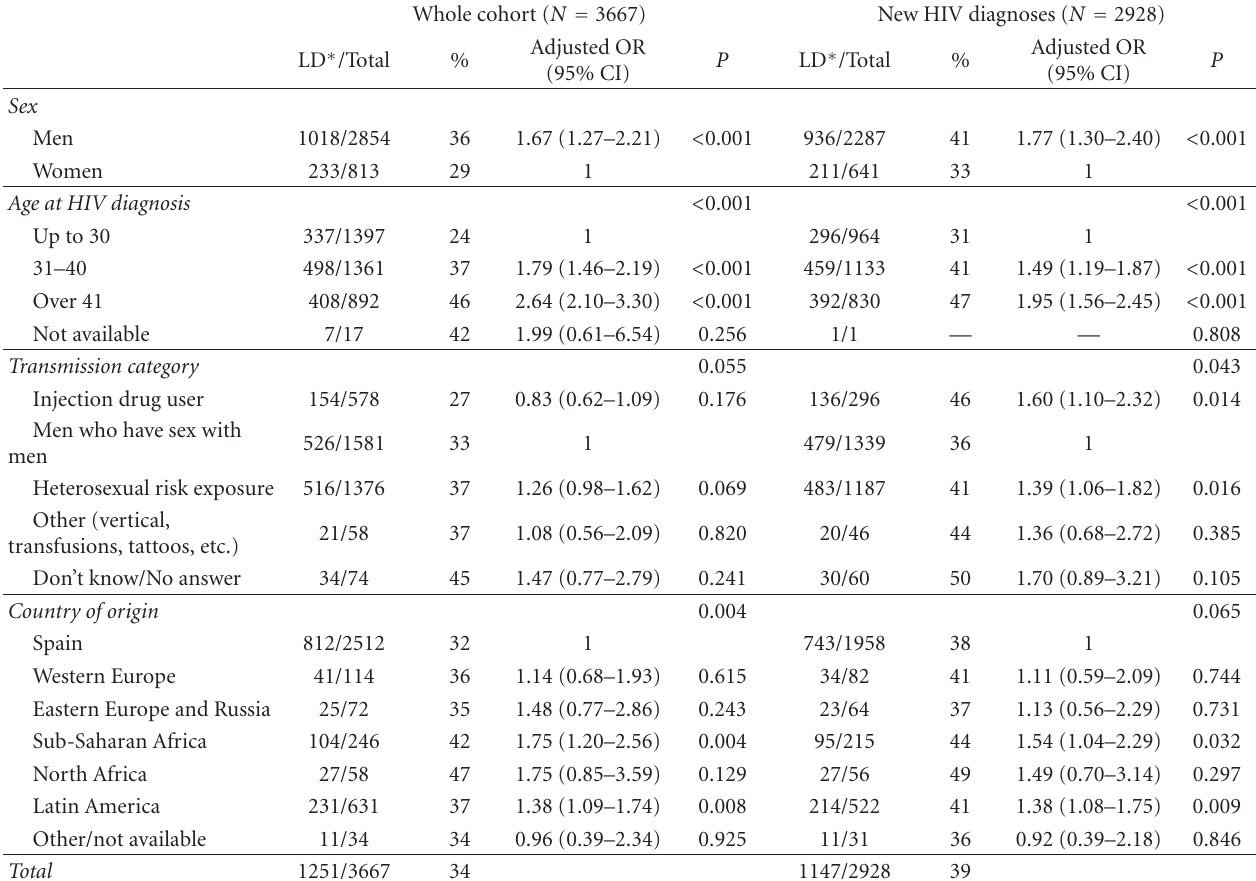
Table 2: Factors associated with late diagnosis (time to HIV diagnosis over 4.19